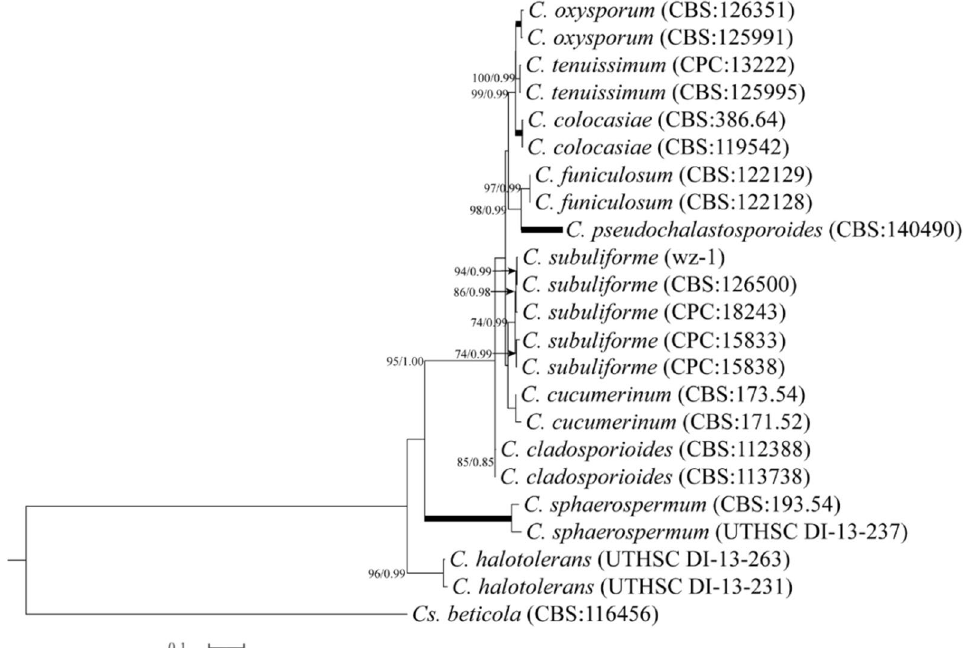
Fig. 2 Maximum likelihood tree inferred from combined ITS , EF-1α , and Act sequences showing the phylogenetic relationships between the isolate wz‑1 and representative members of Cladosporium spp. Branch lengths are proportional to phylogenetic distance. In the ML inference, bootstrap support (BS) value of each split node was estimated using 1,000 bootstrap replicates. In Bayesian inference, two independent sets of Markov chains were run, each with four chains. Each chain was run for 10 7 steps, with samples drawn every 1,000 steps. ML BS values of probability (PP) values of 0.95 are shown above the branches. Tickened branches indicate BS ≥ 116456) was used to root the tree